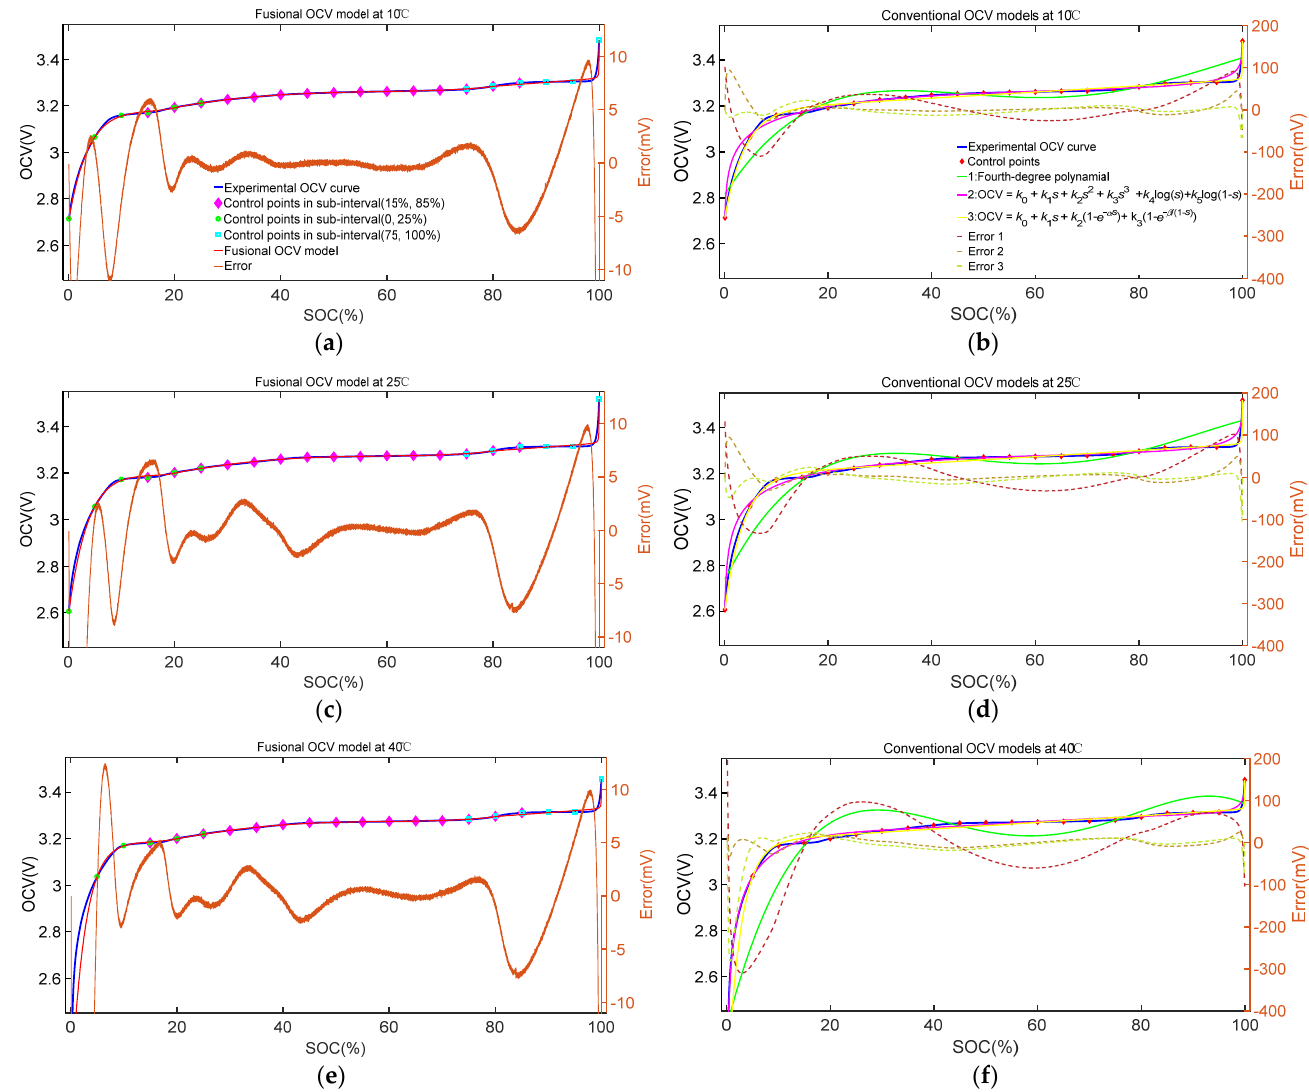
Table 6. RMSE of fusional OCV models and other models for LFP battery (V).